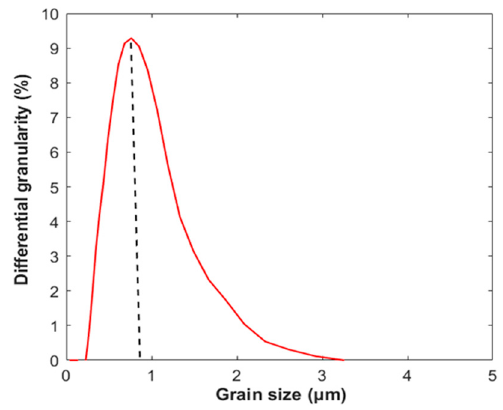
Figure 1. Particle size distribution of calcium silicate hydrate powder. The mineral phases of the synthesized calcium silicate hydrate powder were deter- mined by using X-ray diffraction (XRD, RigakuD/max-1200, Cu K α , Osaka, Japan) with an output power of 3 kW. A step size of 0.02 ◦ , scanning rate of 2 ◦ /min and scanning range from 15 ◦ to 65 ◦ were applied. The XRD pattern of the powders is shown in Figure 2. The diffused peaks can be observed at d-spacings of approximately 1.4 nm (2 θ of 6.5 ◦ ), 0.303 nm (2 θ of 29.4 ◦ ) and 0.182 nm (2 θ of 51.2 ◦ ), which are typical for the amorphous calcium silicate hydrate [30]. In addition, crystalline phases, including α -SiO 2 , α -C 2 SH and calcite, were also detected in the powder. α -SiO 2 with d-spacings of 0.425, 0.334, 0.1819 and 0.1541 nm was derived from the quartz powder. α -C 2 SH is a crystalline calcium silicate hydrate with d-spacings of 0.421, 0.324, 0.277, 0.250, 0.218, 0.179 nm [31]. The presence of calcite was due to the carbonation of calcium silicate hydrate during drying and storage process.